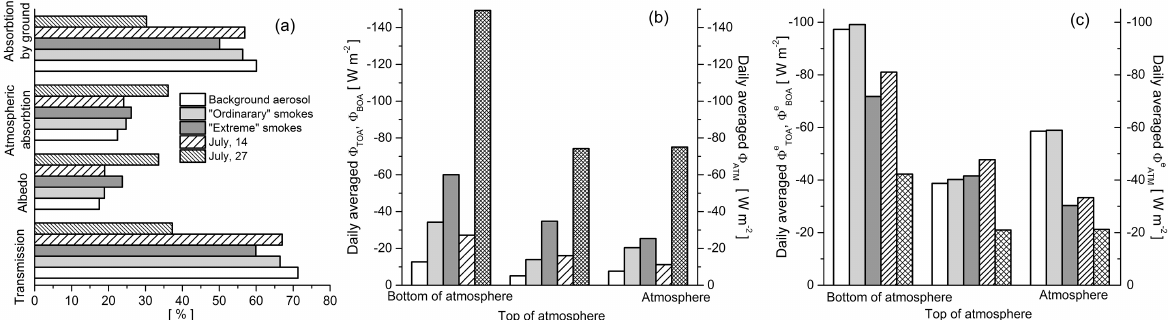
Figure 13. Radiative effects of aerosol under different atmospheric